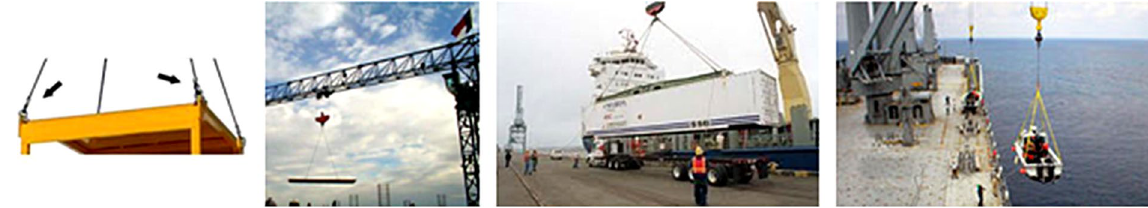
Fig. 1. Sling wire rope application in lifting and transport